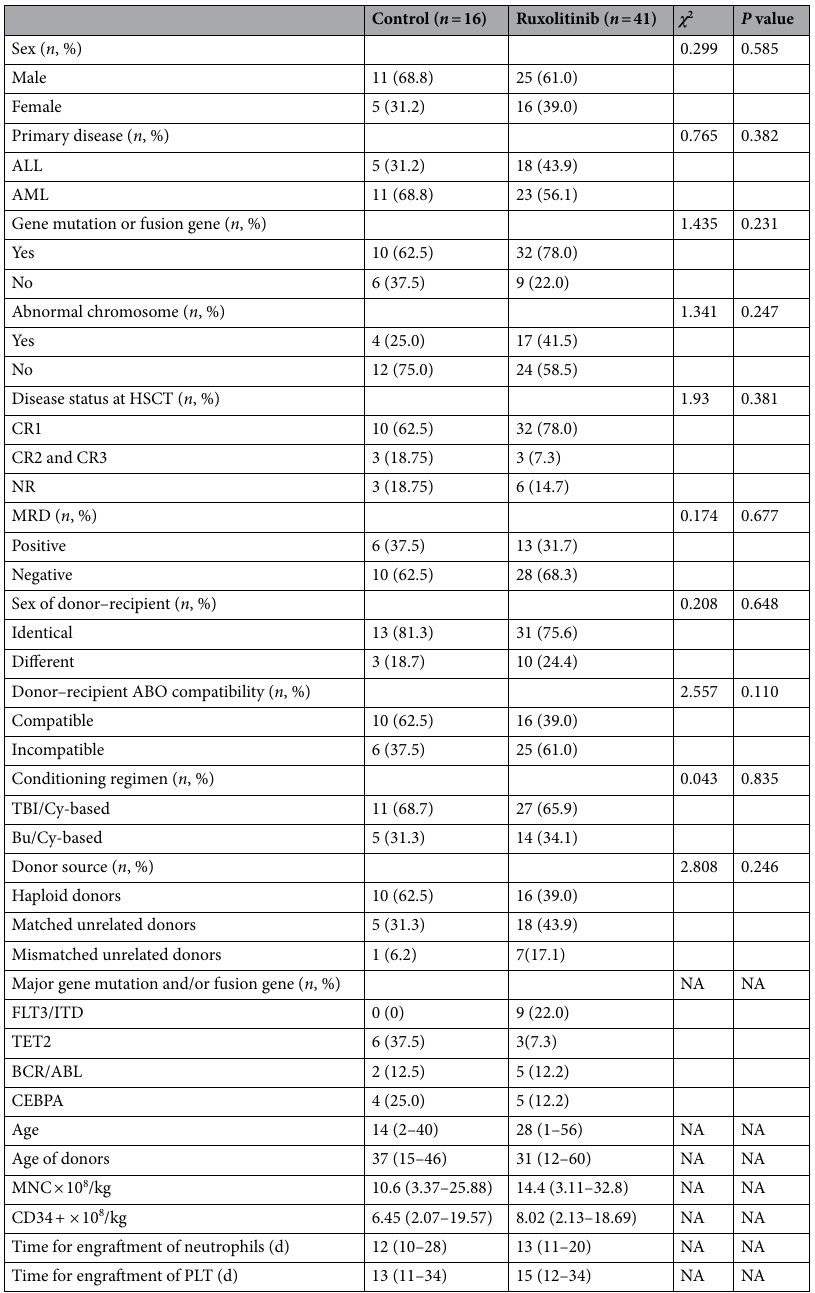
Table 1. Characteristics of all patients in the control and ruxolitinib group ( N = 57). ALL Acute lymphoblastic leukemia, AML acute myeloid leukemia, Bu busulfan, CR complete remission, Cy cyclophosphamide, HLA human leukocyte antigen, HSCT hematopoietic stem cell transplantation, MNC mononuclear cell, MRD minimal residual disease, NA not applicable, NR no remission, PLT platelet, TBI total-body